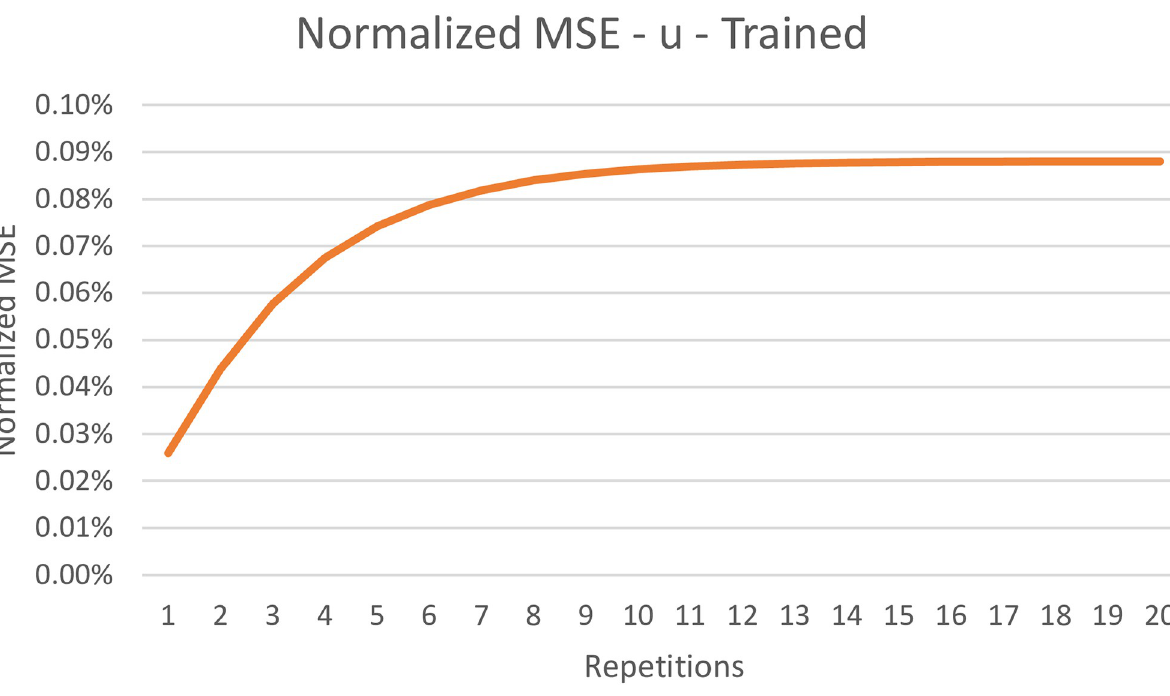
PLOS ONE | https://doi.org/10.1371/journal.pone.0281306 February 17, 2023 9 /